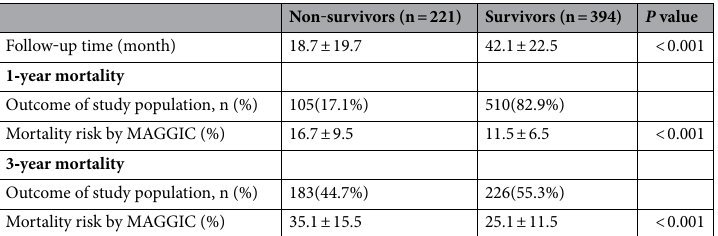
Table 1. Comparison of calculated mortality risk for non ‐ survivors and survivors of non-ischemic dilated cardiomyopathy patients. MAGGIC meta ‐ analysis global group in chronic heart failure, MUSIC MUerte Subita en Insuficiencia Cardiaca. Follow ‐ up time was presented as mean ± SD. The mortality in study population was presented as n (%). Predicted mortality was calculated based on the website (www. heart failu rerisk. org).